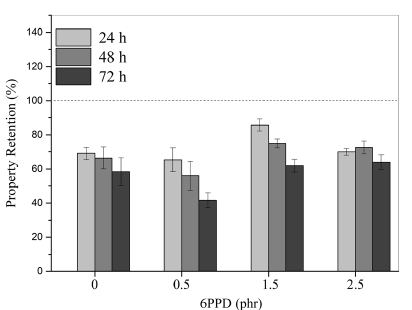
Figure 8. Retention of 6PPD in oven thermo-oxidative aging comprising 1.5 phr of TMQ in combination with different 6PPD contents.